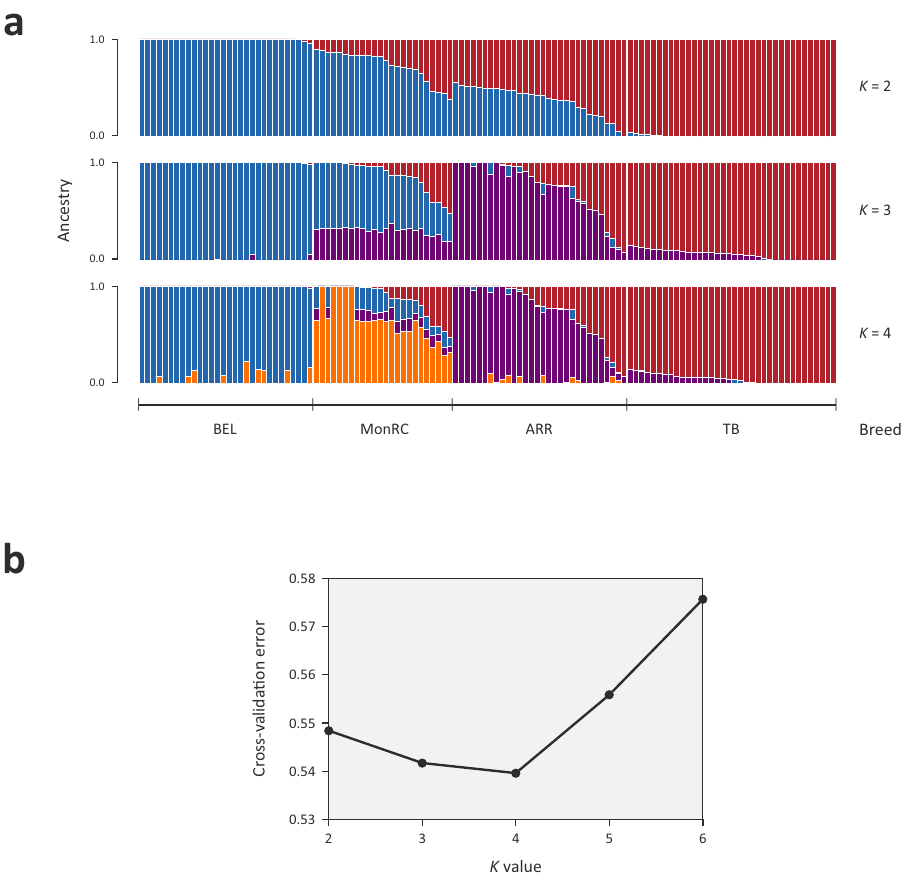
Fig. 2 Admixture analysis among the Racing breeds using Belgian (BEL) as comparator population. a bar plots of ancestry composition by admixture for the assumed number of ancestries K = 2 to K = 4 illustrating the contribution of Thoroughbred (TB) ancestry in the Arabian (ARR) and Mongolian Racing (MonRC) populations. Individual TB contributions to ARR and MonRC are provided in (Supplementary Data 1) b Cross-validation error plot for K = 2 – 6 modelled ancestral (Supplementary Data 3, Fig. 3). Signals on ECA1, ECA7, ECA17 and ECA18 were the highest ranking according to the CSS score.